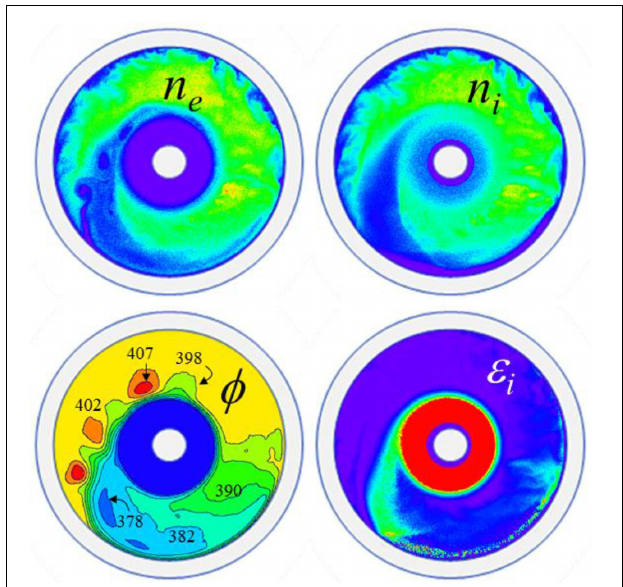
FIGURE 7 | Distribution of the electron density, n e , ion density, n i , electric potential, φ , and ion mean energy ε i at a given time of a steady state magnetron discharge in argon, 10mTorr, applied voltage 400V, magnetic field 30mT. The cathode (inner cylinder) diameter is 1cm and the anode diameter is 5cm. The scales are linear and the (min, max) values are (0, 0 . 3 × 10 16 m − 3 ) for n e and n i , [370, 400V] for φ (the blue region around the cathode is below 370V and includes the cathode sheath), (0, 10eV) for ε i (mean energies much larger than 10eV are reached in the cathode sheath –red region, with a maximum of up to 250eV of the mean ion energy on the cathode surface). The structures appearing on these plots rotate clockwise in about 16 μ s (Same color bar as Figure 3